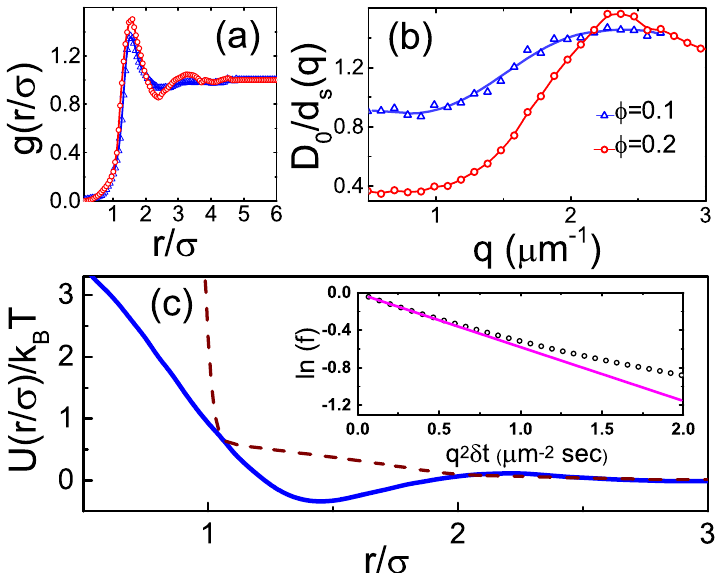
Figure 3. ( a ) The radial distribution function, g ( r ) , at two different volume fractions: φ = 0.1 ( blue triangles) and φ = 0.2 ( red circles). The r values are normalized by σ , as obtained by DLS. The lines are guide to the eye. Note that the position of the first peak, occurring much higher than r / σ = 1, indicates that the colloids are charged. Similarly, the wide first peak is typical for the charged systems. ( b ) The short-time diffusion rates d s ( q ) , as obtained by ConDDM. Note, the y -axis corresponds to the (dimensionless) reciprocal of the diffusion rate, D 0 / d s ( q ) ; the lines are guide to the eye. The d s ( q ) values are obtained by fitting an exponential to the corresponding f ( δ t , q ) , with the fit limited to δ t (cid:28) τ R , as explained in the main text. A typical fit ( pink line) is shown in the inset to panel ( c ), where the experimental f ( δ t , q ) appear in black symbols. ( c ) The pair potential of our PCPMMA (photo-crosslinkable PMMA) spheres (solid blue curve), as obtained by a numerical inversion [34] of the experimental g ( r ) , exhibits a small dip at low r , suggesting that slight interparticle attractions may be present. The curve was obtained by averaging over several different φ , to minimize the numerical noise; the curves at all φ are very close together, validating this averaging. To test the inversion procedure, we carry out a similar inversion for a theoretical g ( r ) of hard spheres ( brown dashes). No attractions are detected in this test case, in a further support of the currently-used numerical protocol